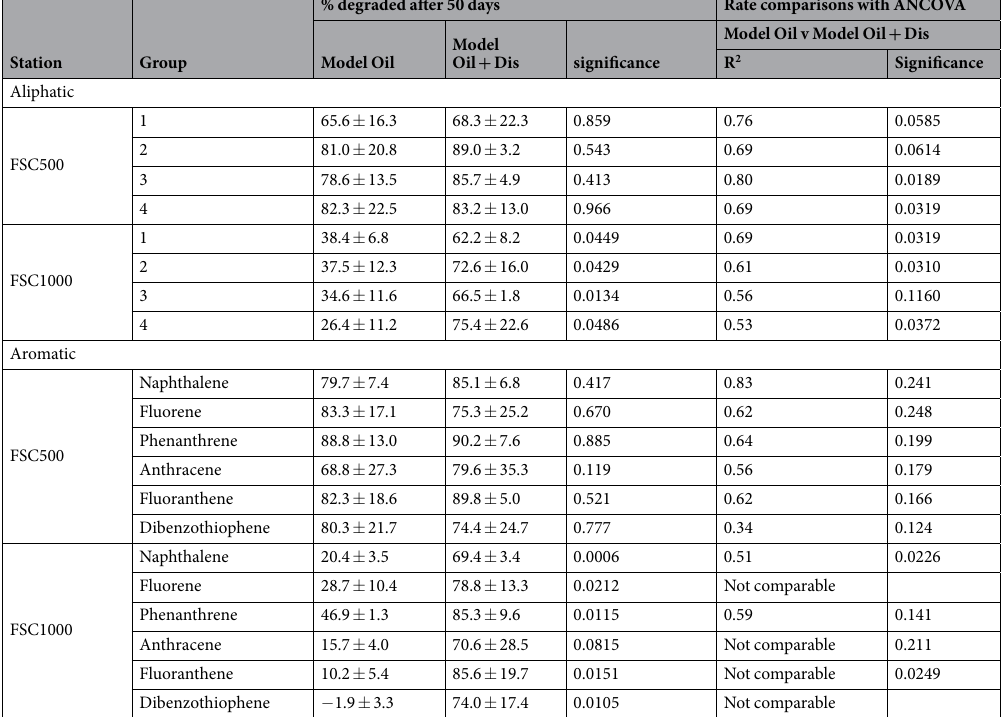
Table 1. Summary of total hydrocarbon degradation for each group after 50 days and results of comparison between rates between model oil and model oil + dis treatments with ANCOVA. n = 15 with 3 per time point for ANCOVA and n = 3 for total degradation after 50